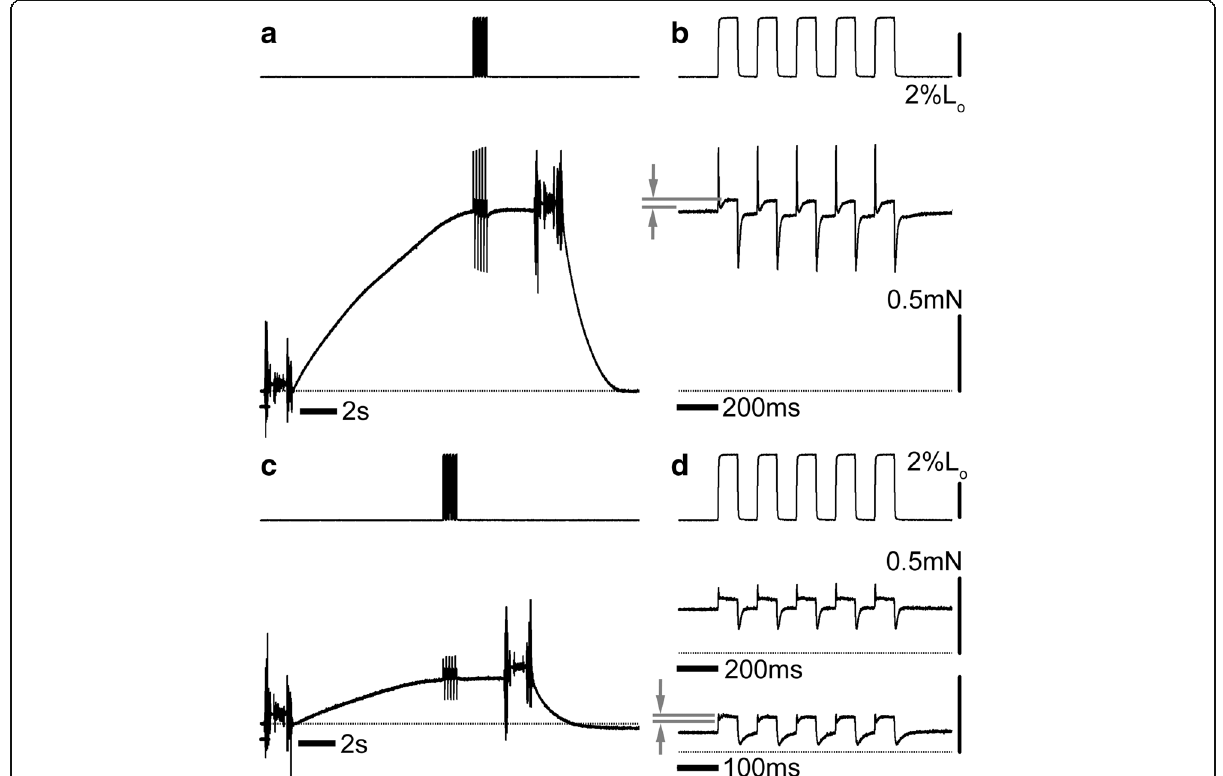
Fig. 6 Mechanical response to the repeated stretches/releases of the calcium-activated DLM ( a, b ) and the tymbal ( c, d ) muscle fibers from Platypleura kaempferi. ( a ) and ( c ), slower time base; ( b ) and ( d ), faster time base. Upper trace, length (stretch upward); lower trace, force. In d , the responses to both 5-Hz and 10-Hz repetitions are indicated. The gap between the two horizontal gray lines (indicated by arrows) is the amplitude of the stretch-activated